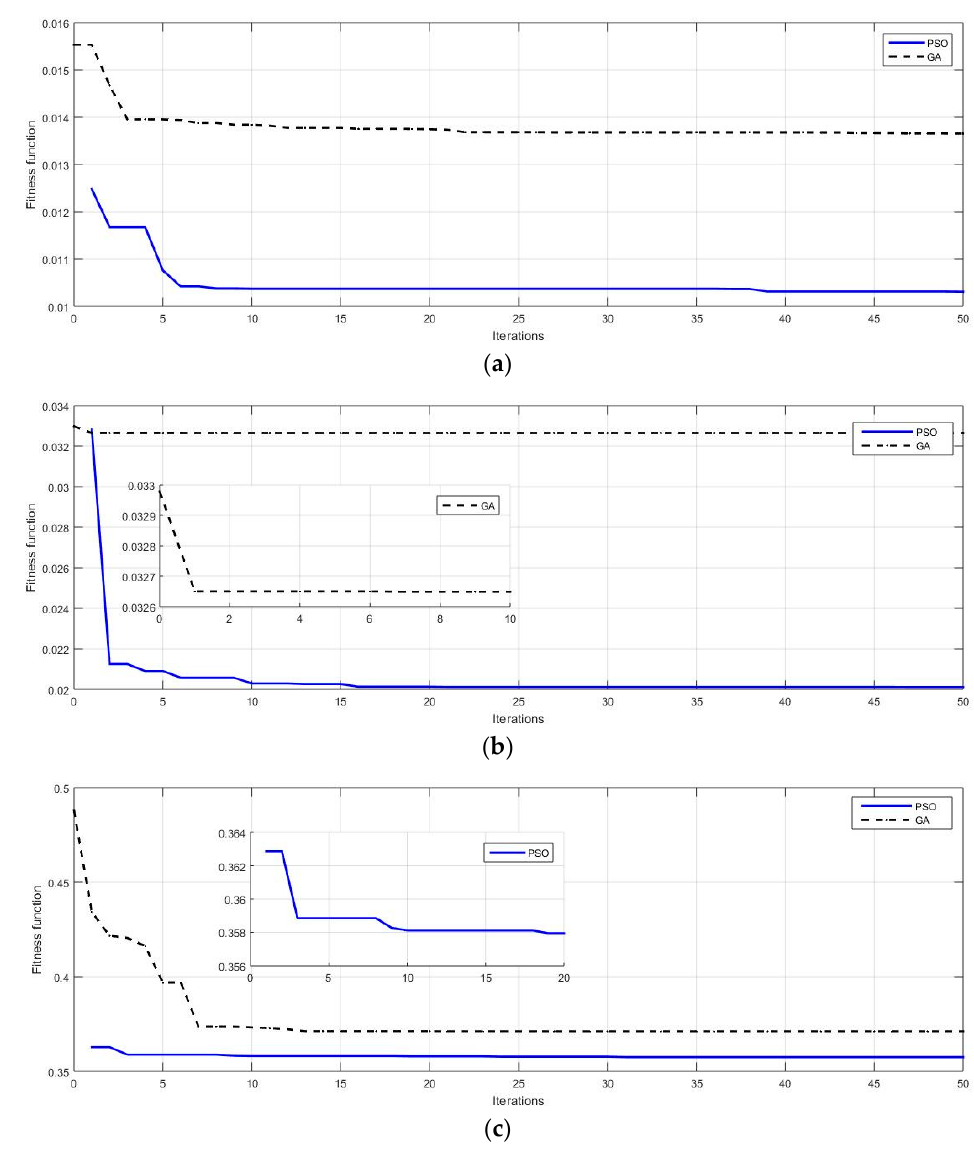
Figure 10. Convergence of PSO and GA for all cases: (a) case 1; (b) case 2; (c) case 3.